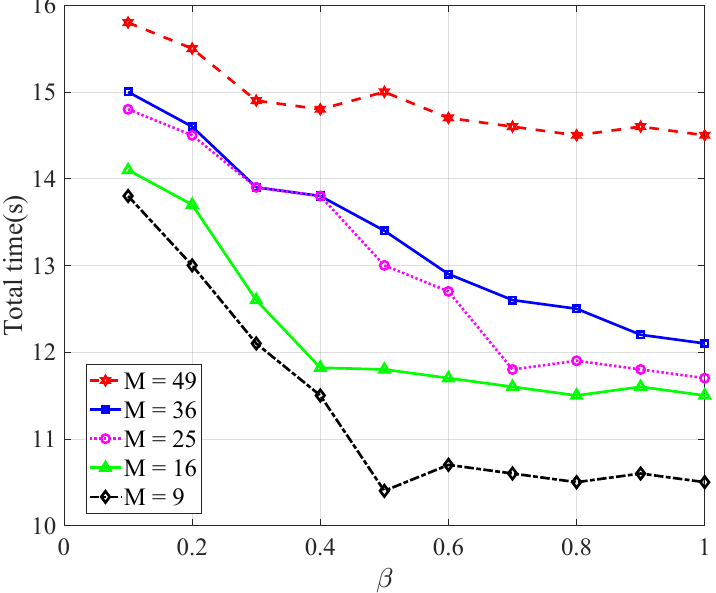
Figure 3. Comparisons of the total times of different schemes versus β